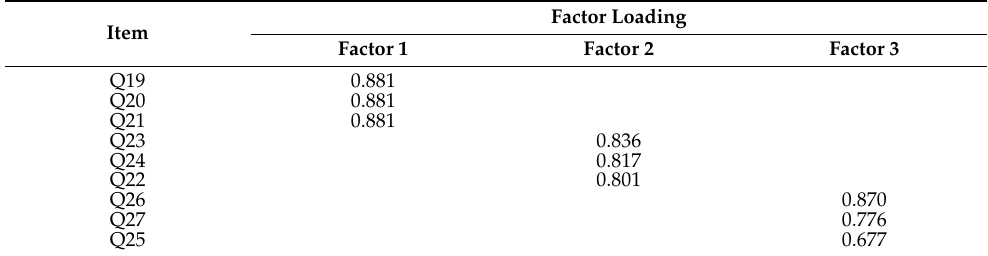
Table 4. Results of the EFA and factor loading for the MCPAQ-MAINT ( n = 225).